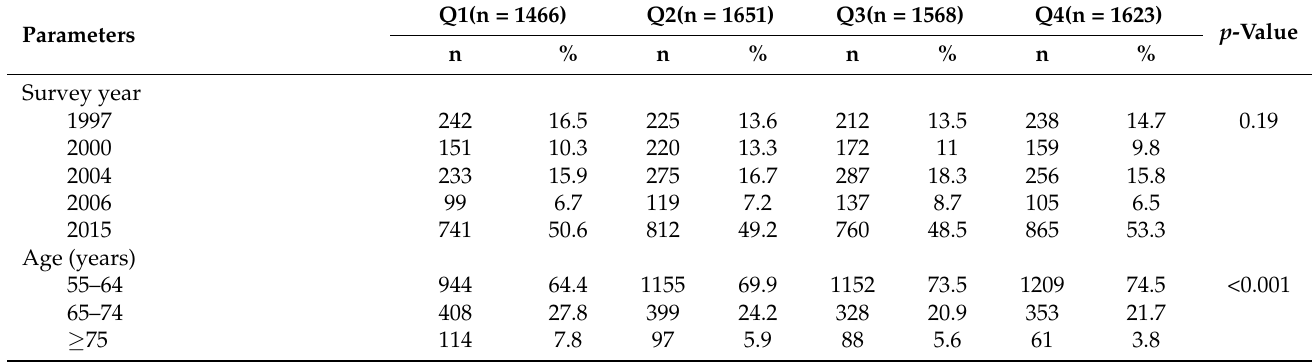
Table 2. Baseline characteristics of Chinese adults aged ≥ 55 years old by quartiles of “vegetable-pork” dietary pattern score (N =